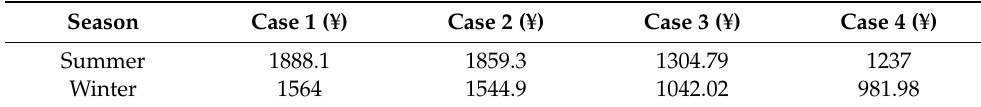
Table 4. Typical daily operation costs of the four cases in winter and